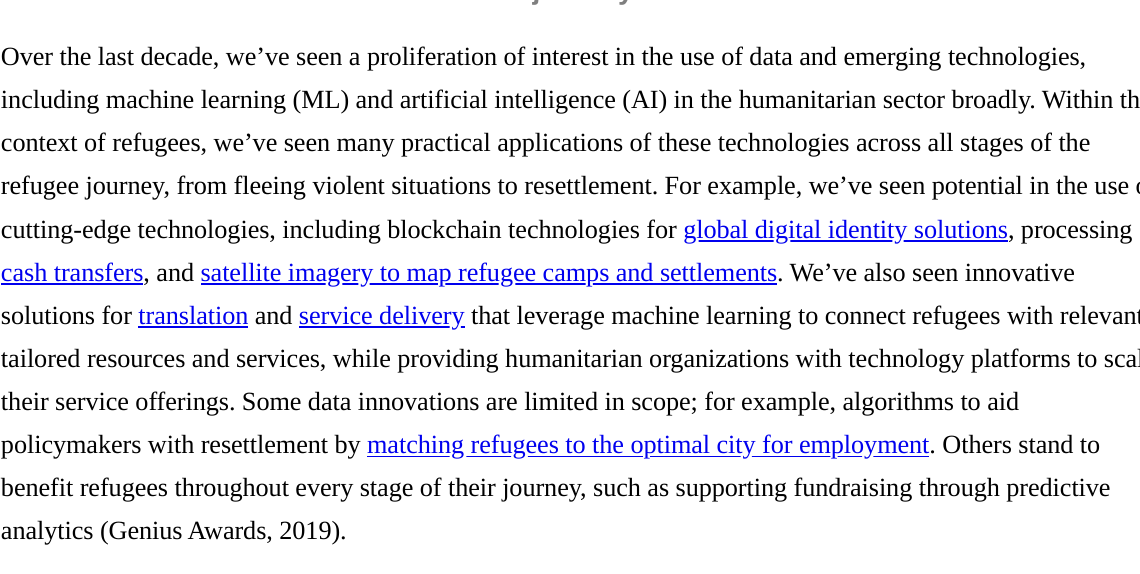
Figure 1. The four stages of the refugee